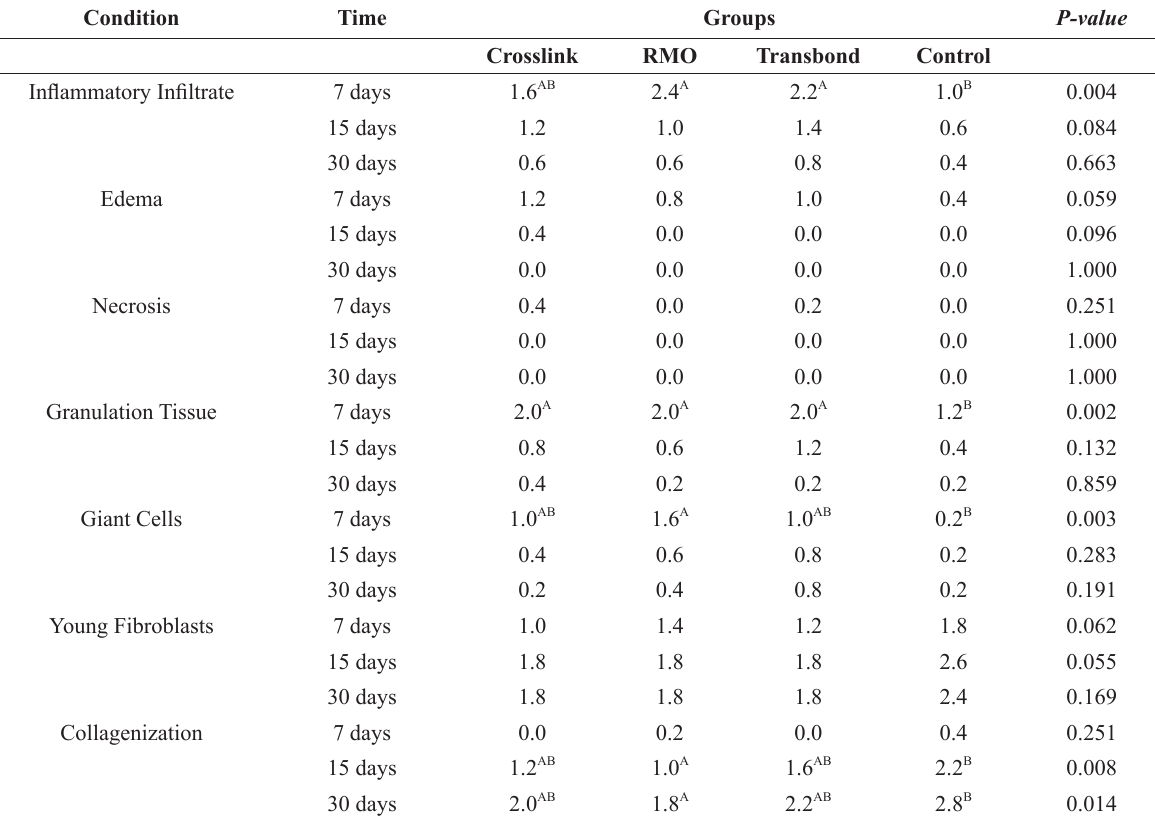
These values represent the mean of scores of the sum of five representative histological sections of the tissue evaluated (n=5, per group). Means followed by different letters express statistically significant difference ( P <05) based on non-parametric Kruskal- Wallis Test, followed by the Dunn multiple comparisons